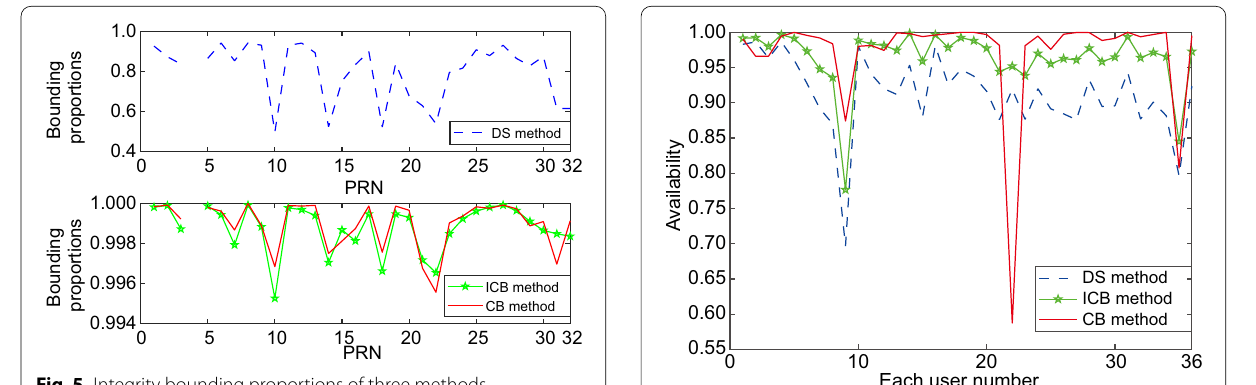
Fig. 5 Integrity bounding proportions of three methods